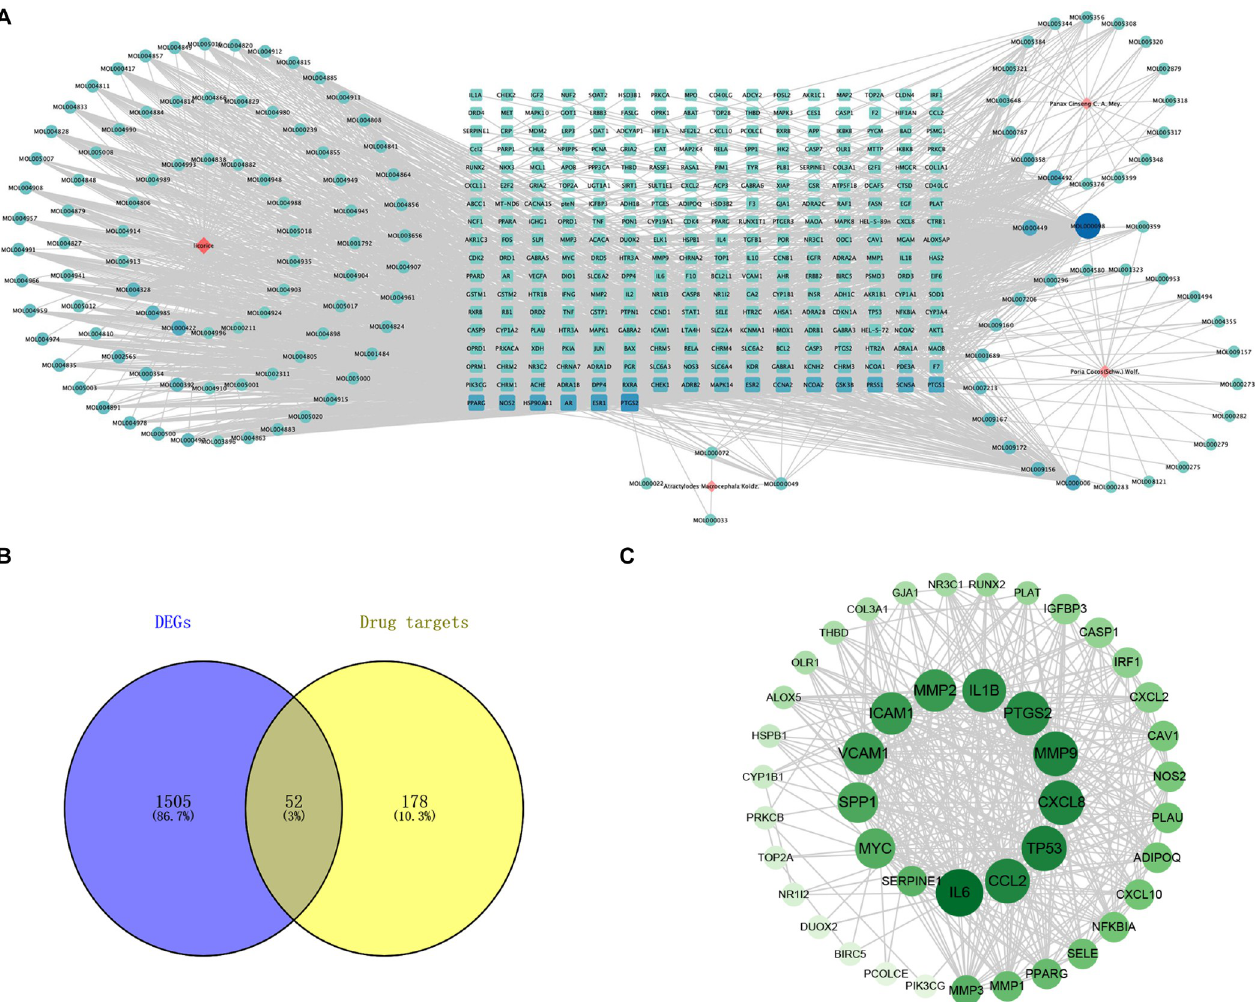
Fig 4. Network pharmacology analysis of SJZD. (A) Drug-active ingredient-target network diagram. The blue nodes are drug targets, and the red nodes are compounds of SJZD. (B) Intersection of 230 therapeutic targets and 1557 DEGs related to SJZD. (C) PPI network diagram of the 52 core genes. The larger nodes in the inner ring represented the most important hub nodes. The smaller nodes in the outer ring represent the other nodes (several nodes with degrees of 1 were deleted).